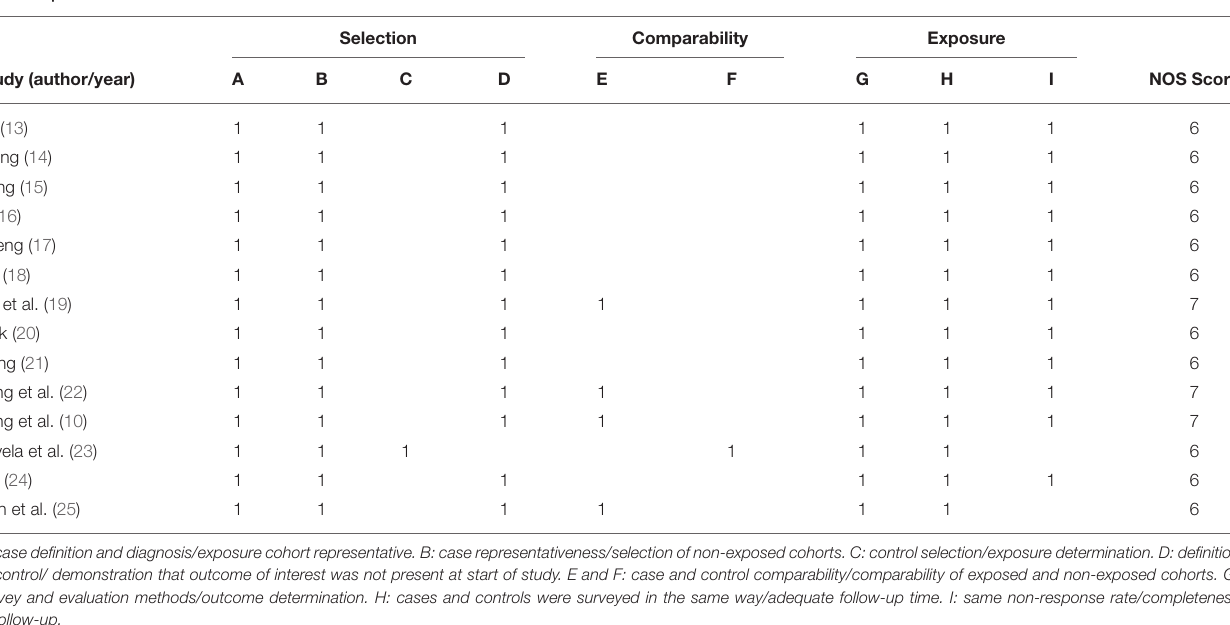
shown in Figure 1 . These 14 articles included 13 retrospective studies and 1 prospective study. A total of 6,196 patients were included in the 14 articles, including 2,558 current smokers,